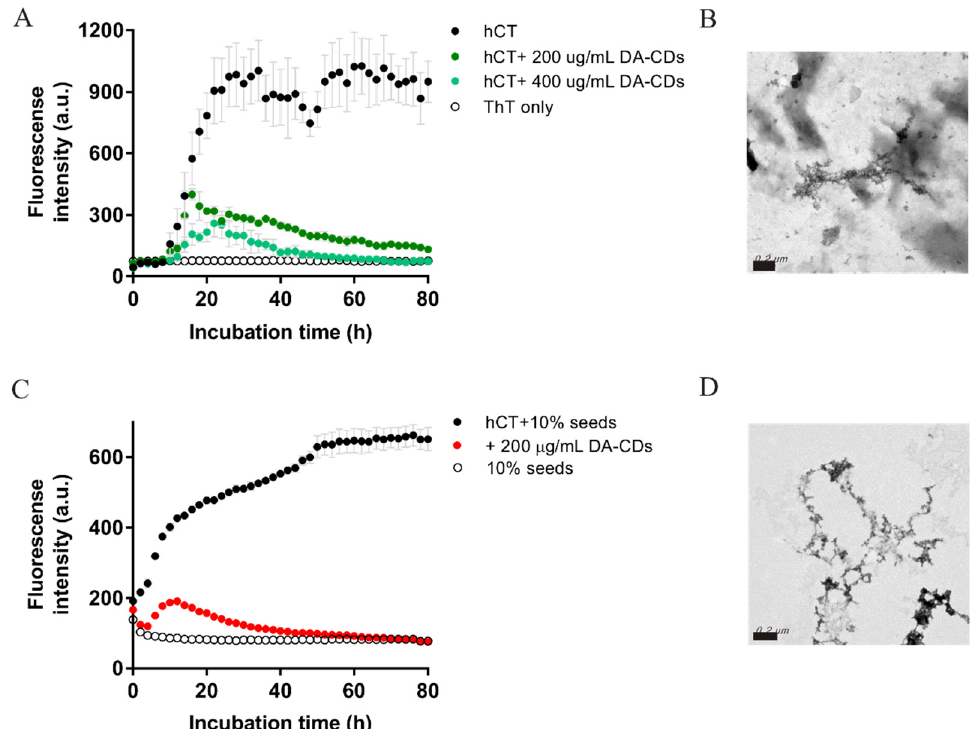
Figure 4. ThT kinetics monitored for hCT fibrillization in the presence of ( A ) lipid vesicles and ( B ) 10% preformed hCT amyloid fibrils used as seeds. TEM images for ThT end products with 200 µ g/mL DA-CDs from conditions in the presence of ( C ) lipid vesicles and ( D ) 10% seeds. Scale bar represents 200 nm.